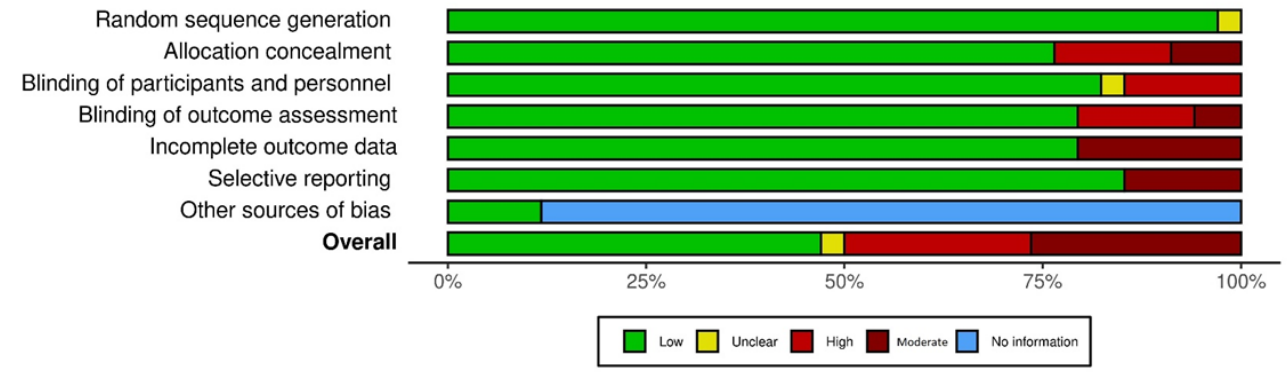
Figure 5. Cochrane risk of bias assessment summary plot. Table 1. Published Cancer Related Fatigue Pharmacological, Nutraceutical and Phyto Pharmaceu- ticals for Treatment Trials and Relevant Summaries.